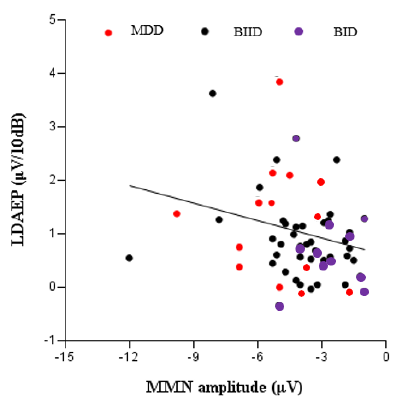
Figure 2. Correlation between LDAEP (loudness dependence of auditory evoked potentials) and MMN amplitude (F3) ( r = −0.30, p = 0.024).